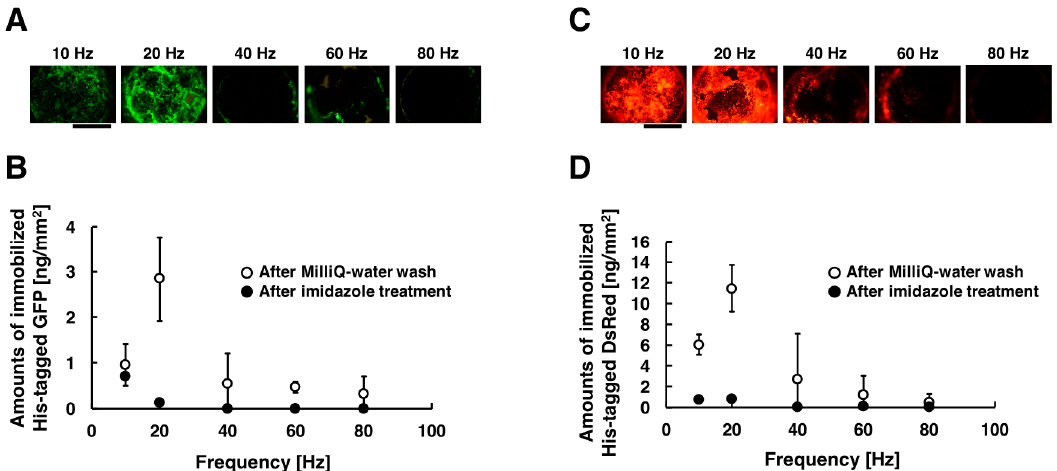
Figure 3. Fluorescent images and amounts of immobilized His-tagged GFP and DsRed by applying AC electric field. The conditions of applying AC electric field are described as follows: 10, 20, 40, 60, and 80 Hz at the constant applied voltage of 80 Vpp for the duration time of 30 min. ( A ) After the application of AC electric field, fluorescence images of immobilized His-tagged GFP. ( B ) After Milli-Q water wash and imidazole treatment, amounts of immobilized His-tagged GFP. ( C ) After the application of AC electric field, fluorescence images of immobilized His-tagged DsRed. ( D ) After Milli-Q water wash and imidazole treatment, amounts of immobilized His-tagged DsRed. Open and closed circle denote the amounts of immobilized His-tagged GFP and DsRed after Milli-Q water wash and imidazole treatment, respectively. Error bars represent the standard deviations from three independent experiments. Scale bar = 1 mm.